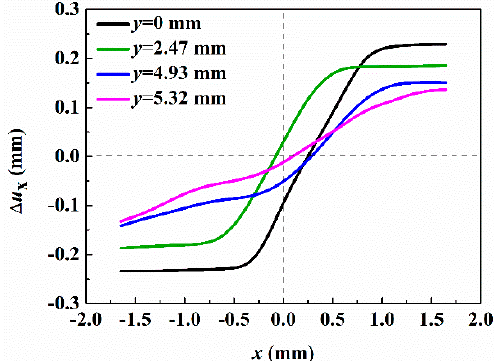
Figure 4. Dry sample: peak and incremental horizontal displacement profiles.